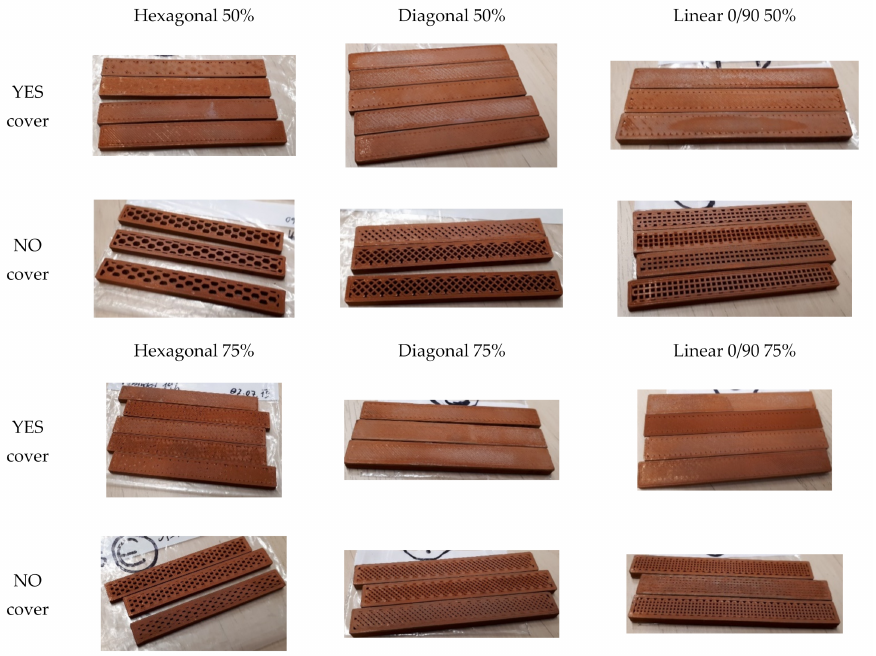
Figure 6. Comparison between bending specimens with the same infill grade and different infill pattern with and without